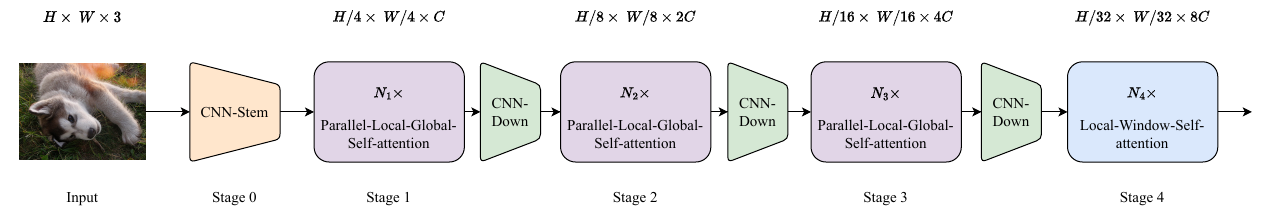
Figure 2. Architecture of our PLG-ViT. Overlapping patches are generated by a CNN stem followed by 3 stages of our parallel local-global self-attention blocks. In the last stage, only local features are ex- tracted. Between the individual stages, convolutional downsampling generates overlapping patches.